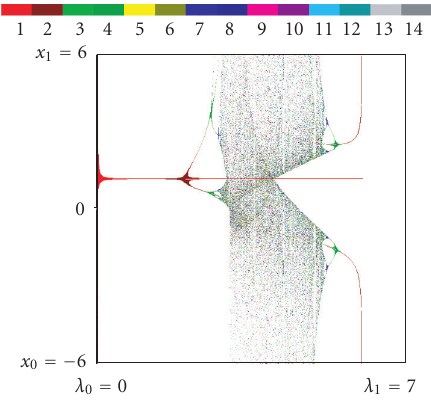
Figure 5.6. Bifurcation diagram of the (cid:2) ( x , λ )